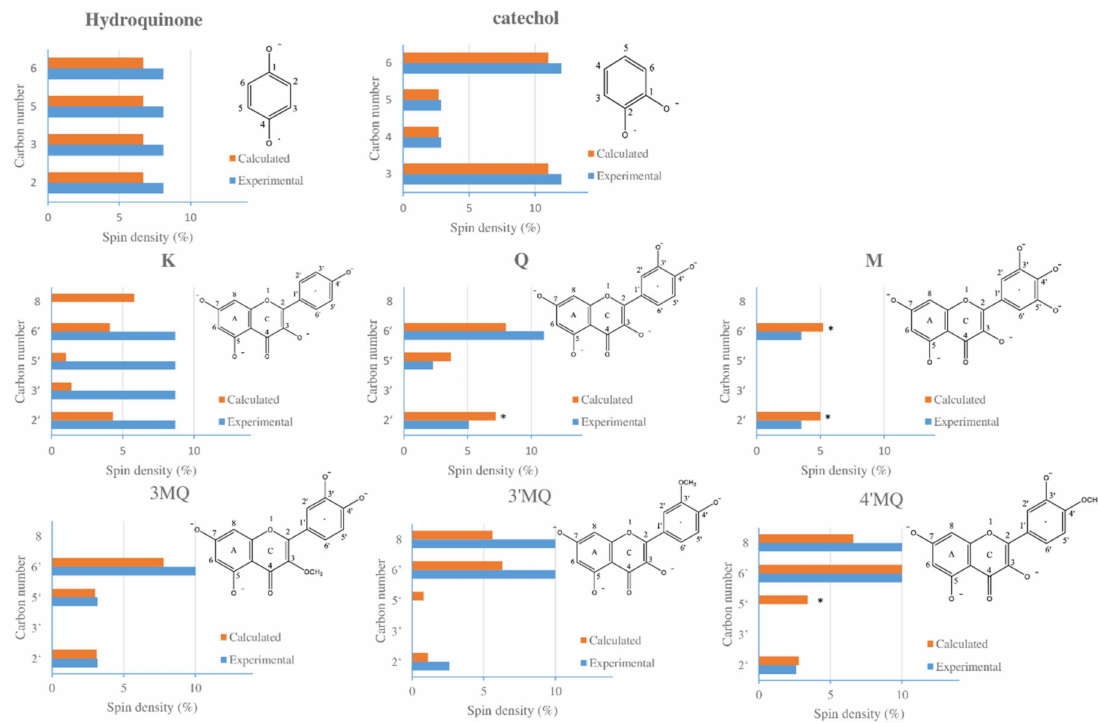
Figure 6. The experimental and calculated spin populations of proton-bound carbons of tested compounds. * representing β electrons (the values of the β electron are negative; for a better comparison, we used absolute values in the picture above, noting that the calculated spin populations are in percentages. This also applies to the whole text when talking about calculated